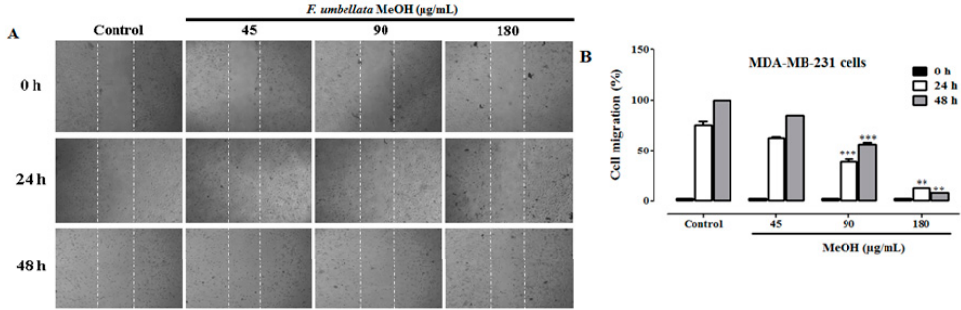
Figure 4. Effect of F. umbellata MeOH extract on cell migration potential. Microphotographs of one assay ( A ); and graphic representation of three independent wound-healing assay ( B ) in MDA-MB-231 cells migration after 24 and 48 h of treatment. ** p < 0.01, *** p < 0.001 as compared with